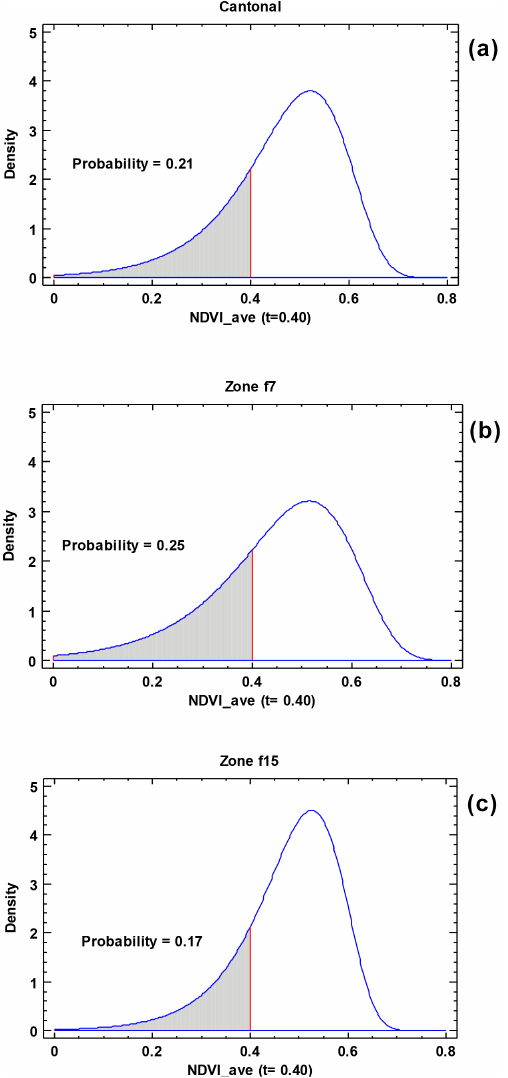
Figure 4. Physiological threshold (red line) within generalized- minimum extreme value (GEV min ) distribution of NDVI_ave; (a) cantonal and (b) f7 and (c) f15 zones.